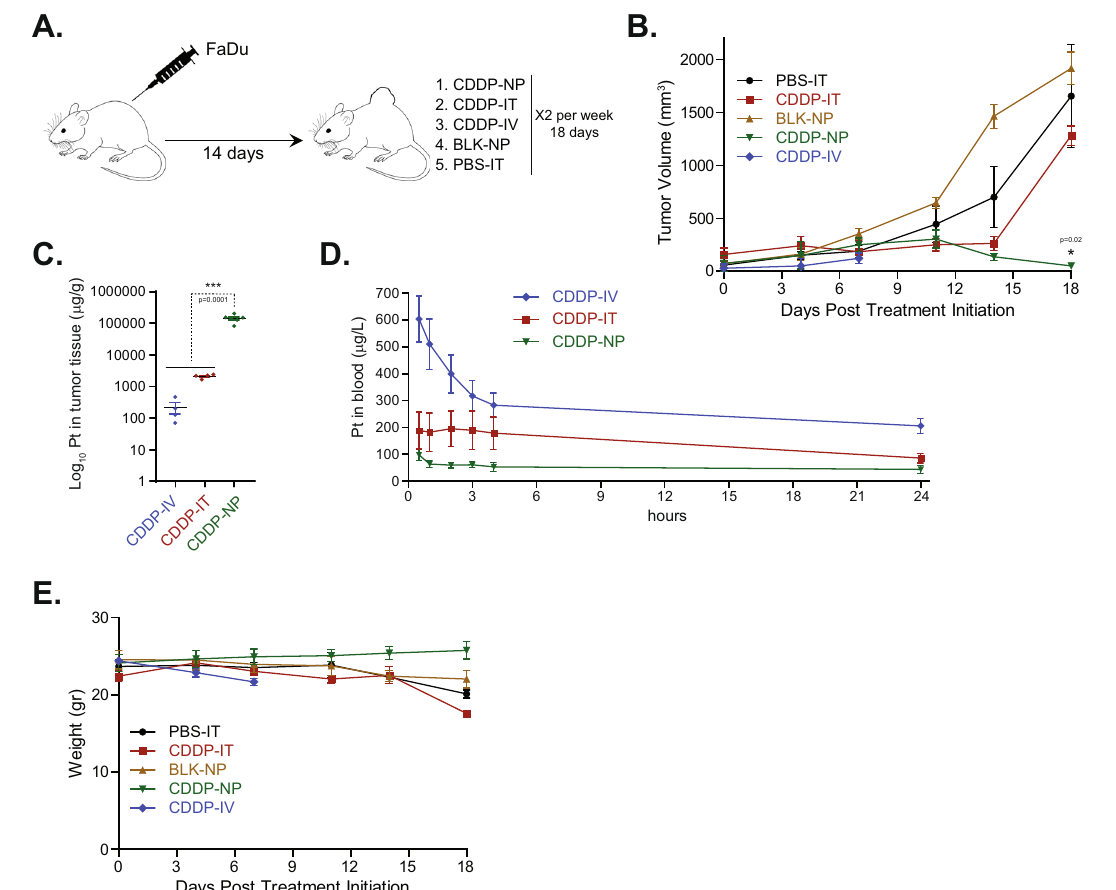
Fig. 1 Cisplatin chitosan nanoparticles (CDDP-NP) demonstrate improved local drug retention and induce potent anti-tumor response in FaDu tumor bearing mice xenografts. A Schematic representation of the experiment. B Nude mice xenografts bearing subcutaneous human FaDu HNSCC cell line induced tumors were treated with either PBS-IT, CDDP-IT, CDDP-IV, BLK-NP, or CDDP-NP. Graphs show the average tumor volume for 6 animals per group ± SEM. P-value was performed by a 1-sided Wilcoxon Rank-sum Test. Asterisk represents statistical signi fi cance between the CDDP-IT and CDDP- NP groups ( p < 0.05). C Residual tumors were harvested after 4 treatments (day 14) for CDDP-NP ( n = 6) or CDDP-IT ( n = 4) and 2 treatments (day 7) for CDDP-IV ( n = 4). Samples were weighted, homogenized and cisplatin level was quanti fi ed by ICP-MS, shown as average ± SEM ( p < 0.0001; Student ’ s unpaired t -test). D Blood was collected from 4 animals per group after administration of the fi rst dose at indicated time points and level of cisplatin was quanti fi ed by ICP-MS, shown as average ± SEM. E Graph shows the average body weights for 6 animals per group ± SEM. Source data are provided as a Source Data fi